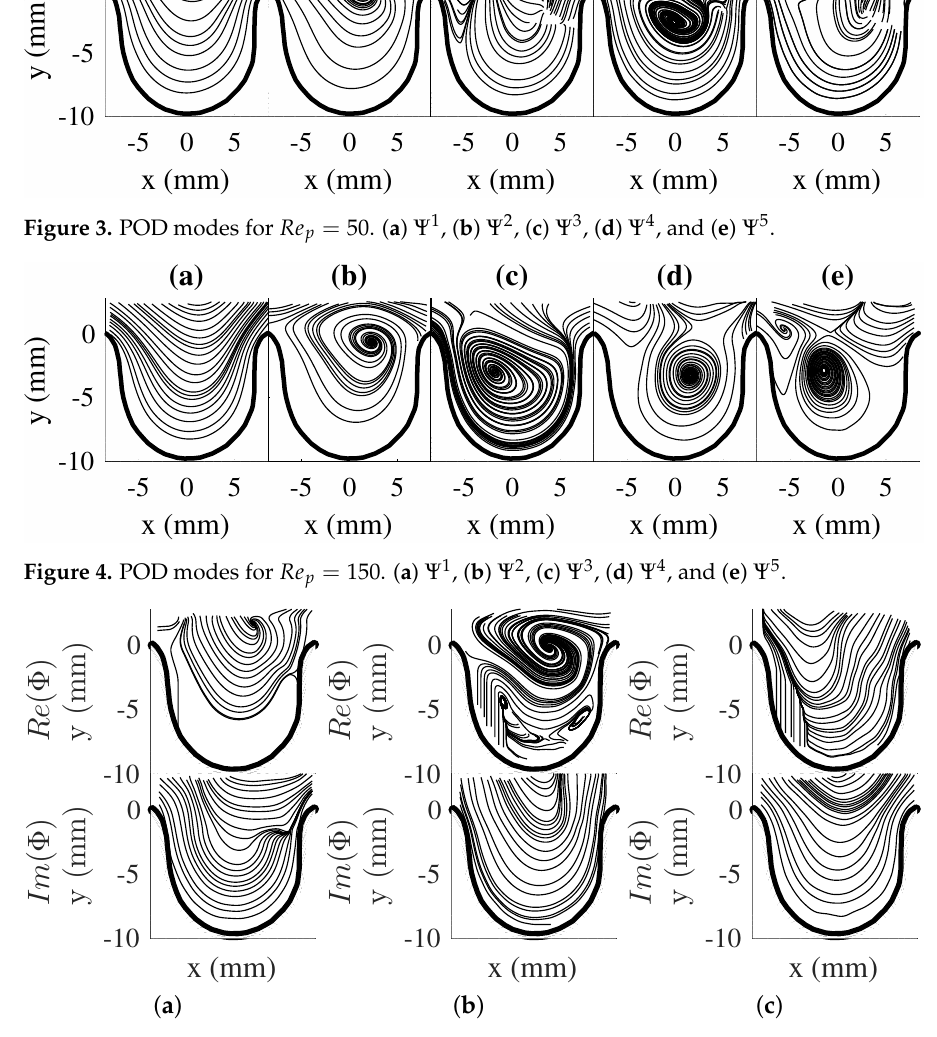
Figure 5. DMD modes for Re p = 50. ( a ) 0.4 Hz mode, ( b ) 0.8 Hz mode, ( c ) 1.6 Hz